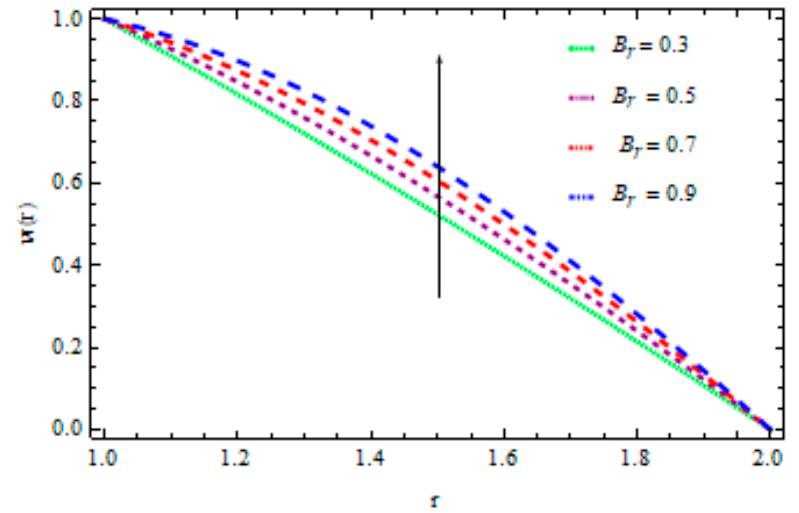
Figure 2. The influence of B r on velocity distribution in case of Reynolds’ model when Q = 0.2, K p = 0.1, ε = 0.6, N = 0.1, m = 0.1, β 0 = 0.1.